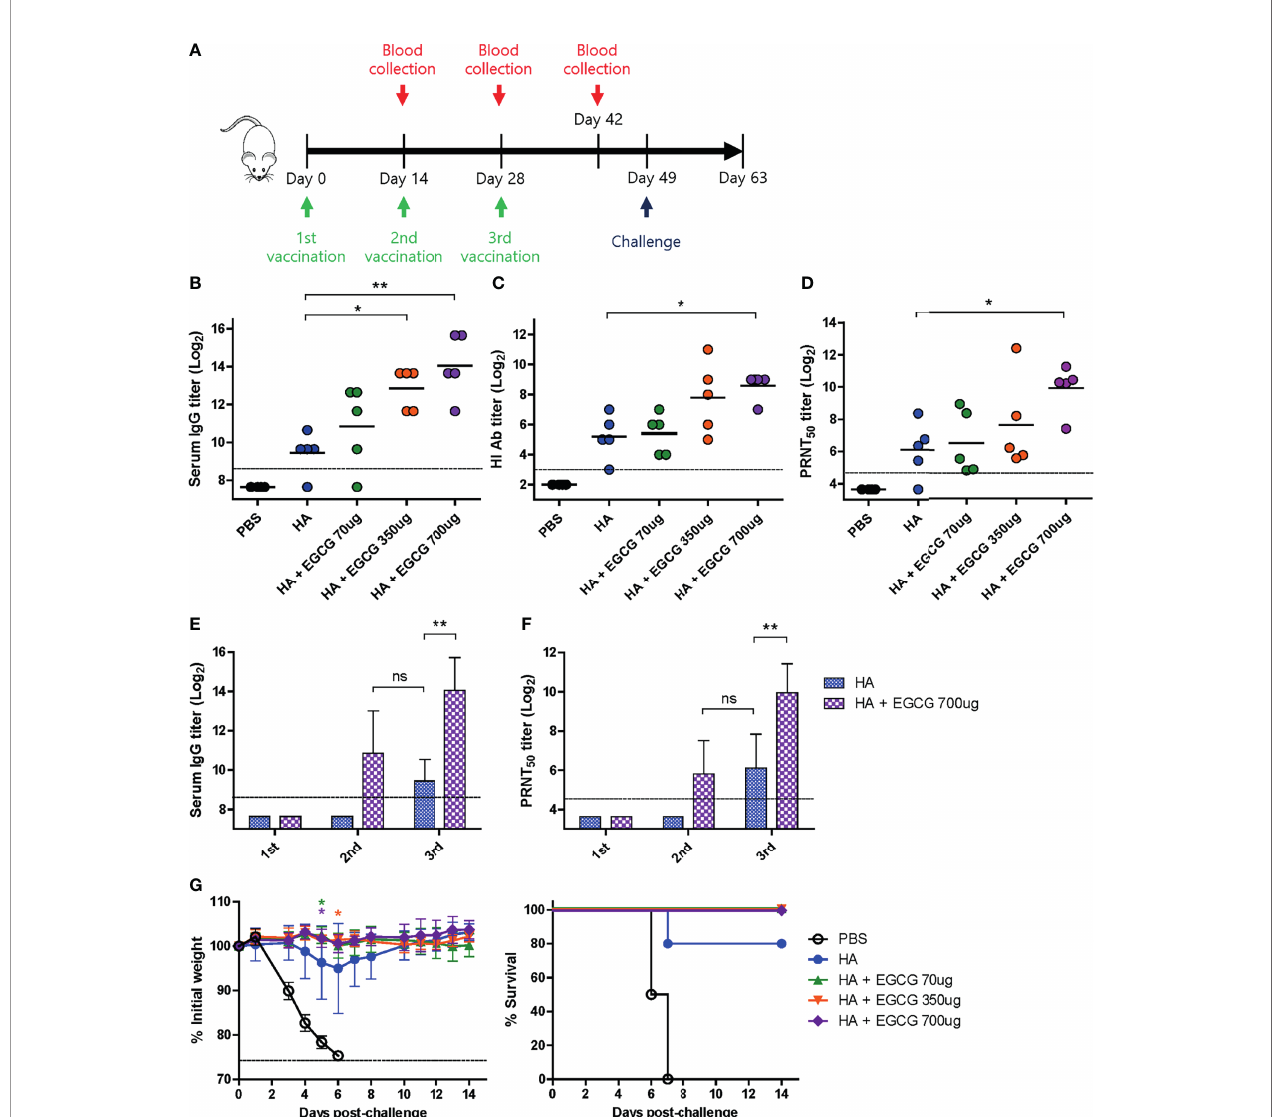
FIGURE 3 | Dose-dependent adjuvanticity of EGCG. PBS or 7 µg of HA antigens with or without adjuvant (70, 350, or 700 m g of EGCG) were injected into mice via IM route thrice every 2 weeks. (A) Vaccination, blood collection, and challenge schedule. (B) IgG antibody response to in fl uenza PR8 virus. The antibody titer of each sample was expressed as the endpoint dilution with an absorbance value 2× greater than that of the PBS control group. Data were log-transformed and expressed as means (horizontal lines) and scatter plots. The detection limit (dashed line) was 400. (C, D) Neutralizing antibody responses to in fl uenza PR8 virus. HI antibody titers (C) and PRNT 50 titers (D) against the PR8 virus. Data were log-transformed and expressed as means (horizontal lines) and scatter plots. The detection limits of the HI assay and PRNT (dashed lines) were 8 and 25, respectively. (E) IgG antibody response to in fl uenza PR8 virus depending on the number of vaccine doses. Data were log-transformed and expressed as means (bar graphs) and standard deviations (error bars). The detection limit (dashed line) was 400. (F) Neutralizing antibody responses to in fl uenza PR8 virus depending on the number of vaccine doses. Data were log-transformed and expressed as means (bar graphs) and standard deviations (error bars). The detection limit (dashed line) was 25. (G) Protective ef fi cacy against in fl uenza PR8 virus. The vaccinated mice were challenged with 4 × 10 3 PFU (4 MLD 50 ) of in fl uenza PR8 virus after the last vaccination. Dashed line indicates humane endpoint which means losing 25% weight loss. Mice that lost >25% body weight were euthanized. Data of the changes in weight ( G , left panel) are shown as means (points) and standard deviations (error bars). Student ’ s t -test was used to compare two different groups. One-way ANOVA followed by Tukey ’ s multiple comparison test was conducted to compare three or more groups. Repeated measures two-way ANOVA followed by Bonferroni ’ s post-test was used to analyze weight changes for different mouse groups over time. Each group was compared with the group given the non-adjuvanted HA (** P < 0.01; * P < 0.05. ns, not signi fi